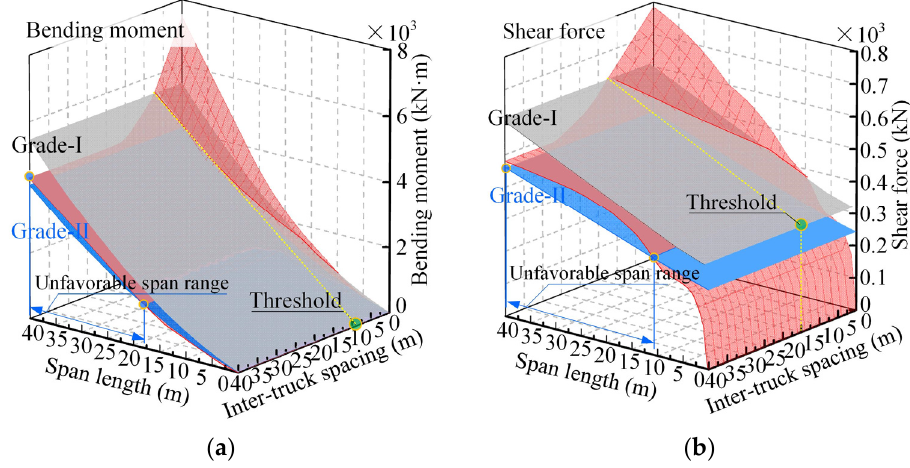
Figure 7. Load effects of simply supported bridges due to two-truck (55 t) ATP loads: ( a ) bending moment; ( b ) shear force.